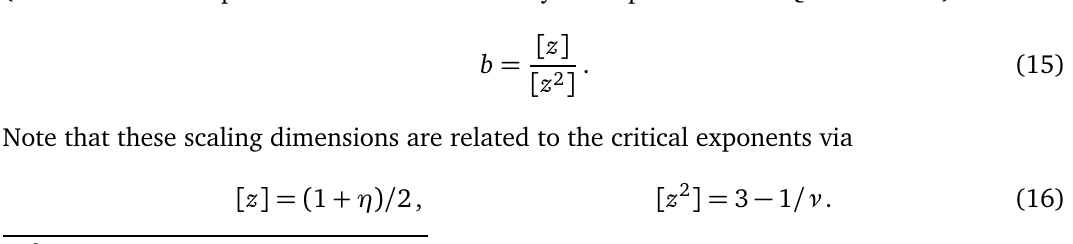
Figure 6: Due to the duality (7) which takes α → 1 − α , a nonzero slope dE signals a first order transition between the trivial and SPT phases. Moreover, due to the Hellmann-Feynman theorem (13), the slope also measures the order parameter for the U ( 1 ) superfluid which spontaneously breaks the pivot (2). We see that the slope (dashed lines) obtained by fitting the data with a cubic polynomial (solid lines) is non-vanishing for J = 0.25, while it is approximately flat for J = 0 (both are shown with the same scale for